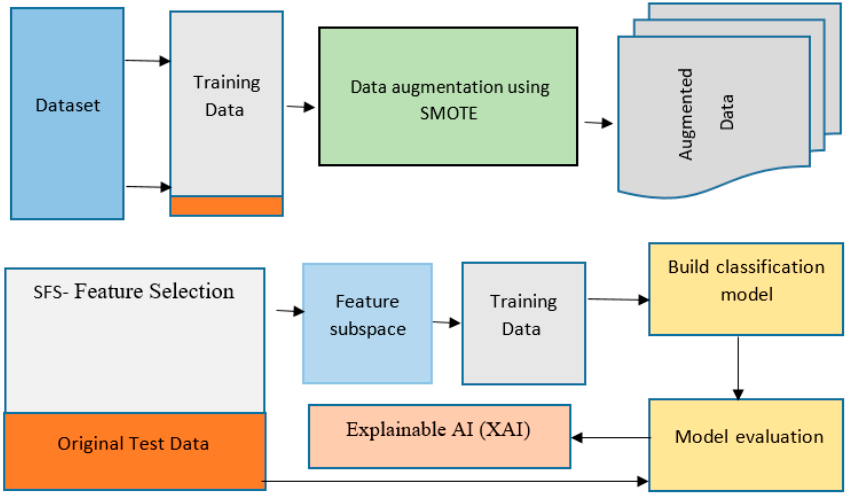
Figure 2. Framework for research methodology.